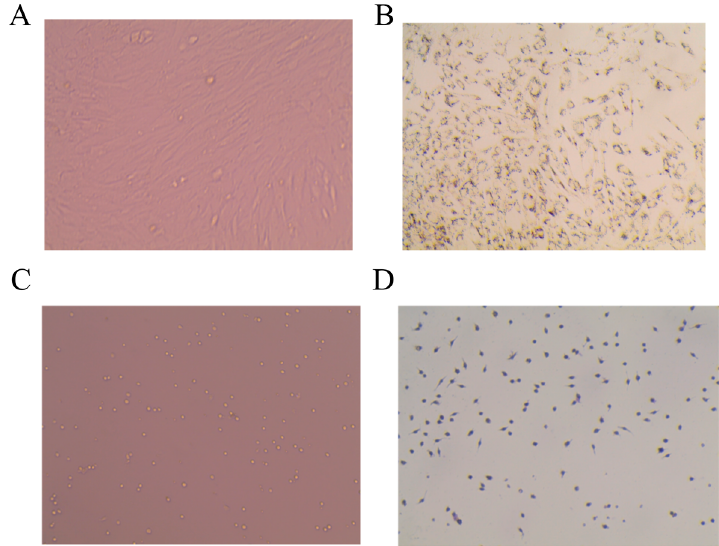
Figure 2. Morphological observation of adipose stem cells and peritoneal macrophages in primary culture mice. ( A ) ADSC (20×). ( B ) ADSC, oil red O staining (20×). ( C ) PM (20×). ( D ) PM-immunohistochemical CD68 staining (20×).